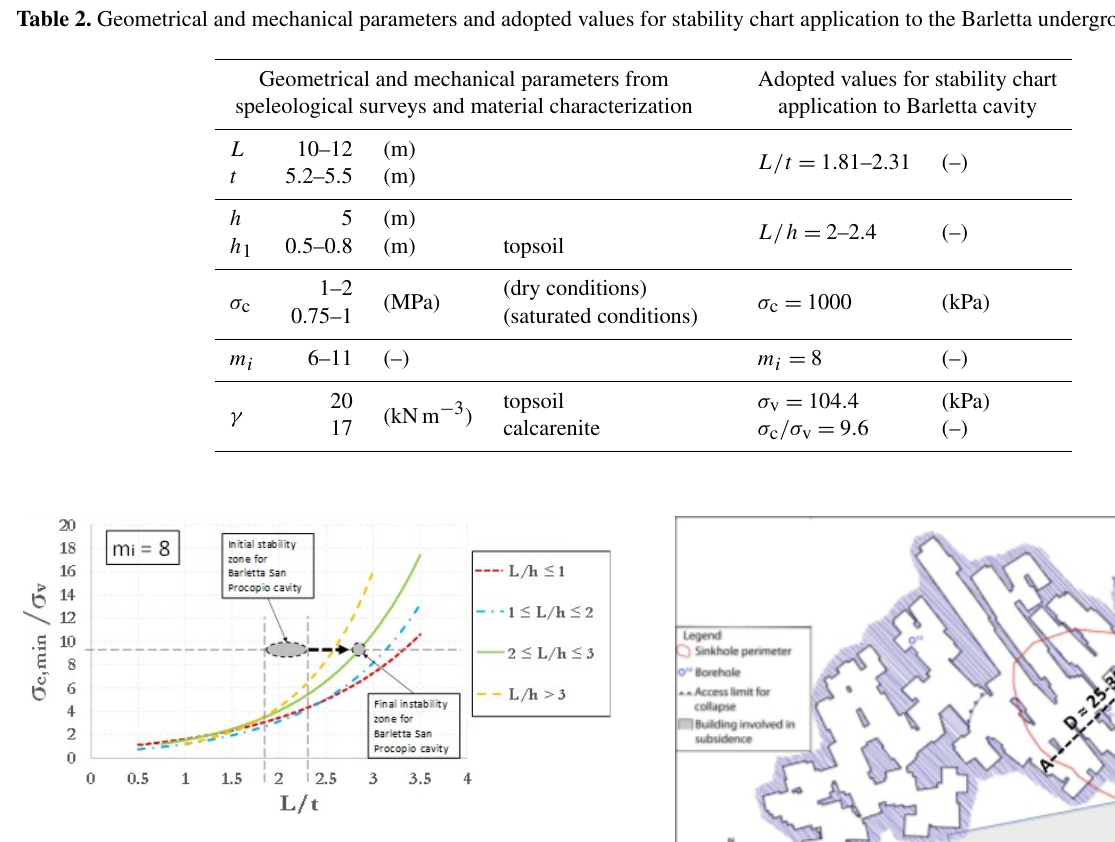
Figure 8. Application of stability chart ( m i = 8) for the Barletta case study.